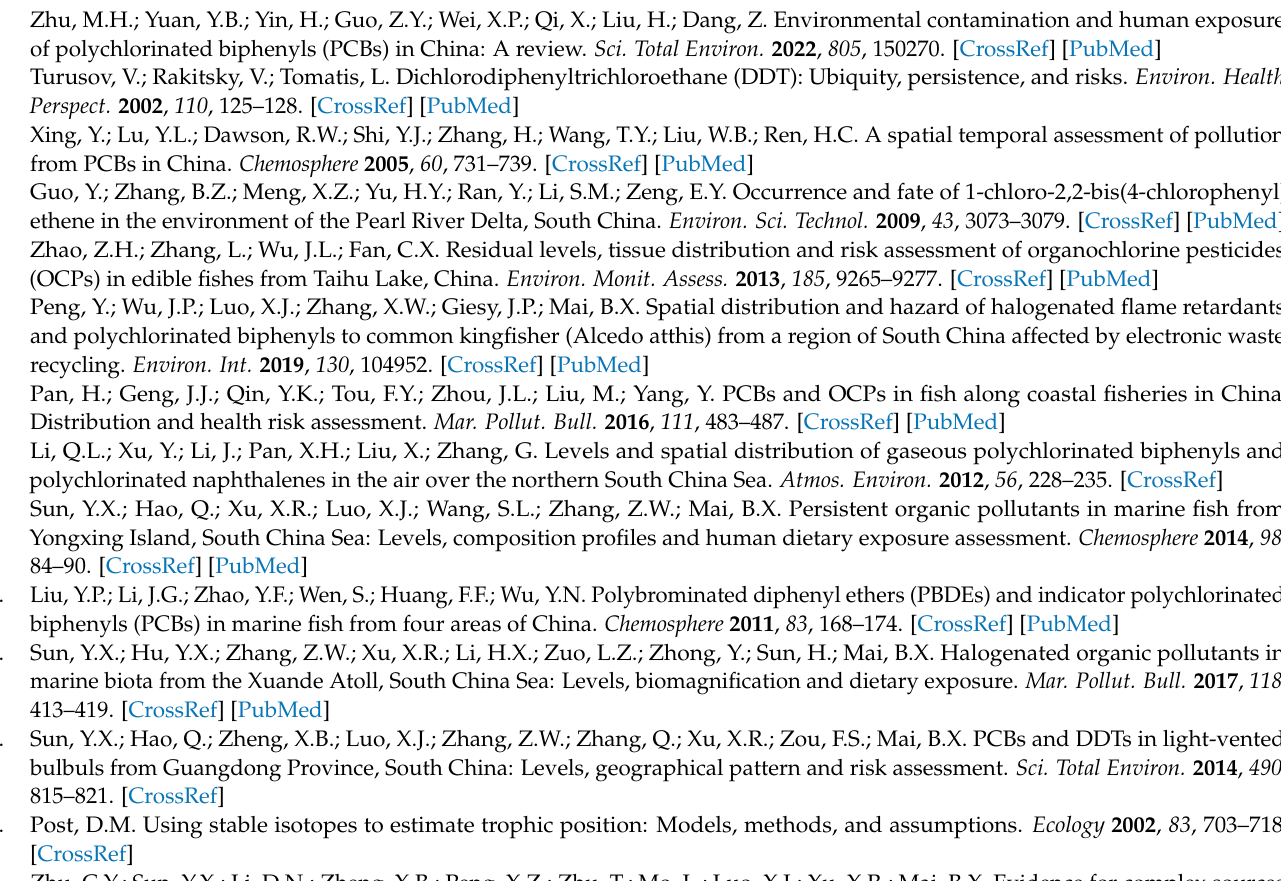
Figure S3: Relationships between concentrations of PCB congeners and δ 15 N in biota species from Qilianyu Island; Figure S4: Relationships between concentrations of p,p (cid:48) -DDE and δ 15 N in biota species from Qilianyu